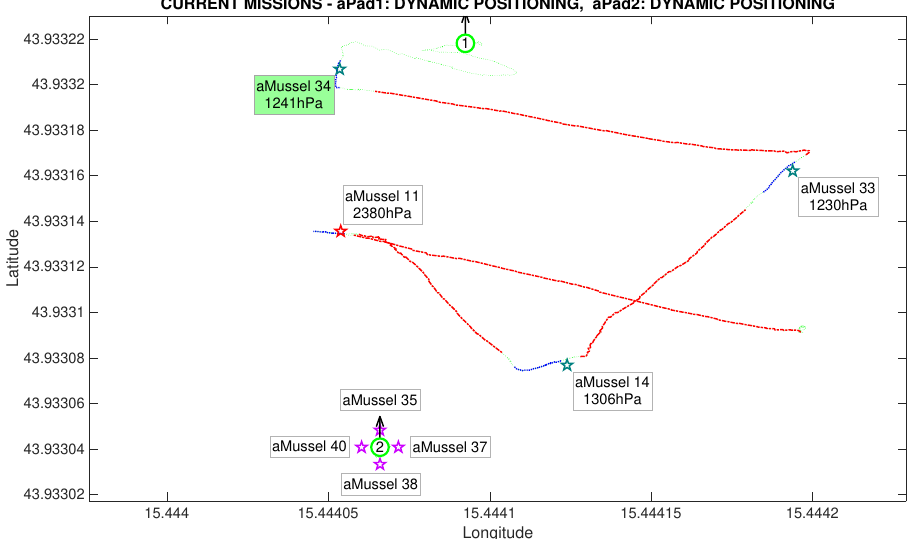
Figure 13. Outlier detection started in the Anoxia scenario experiment results from the deployment phase, reconstructed and replayed from recorded vehicle data—Biograd na Moru testbed.